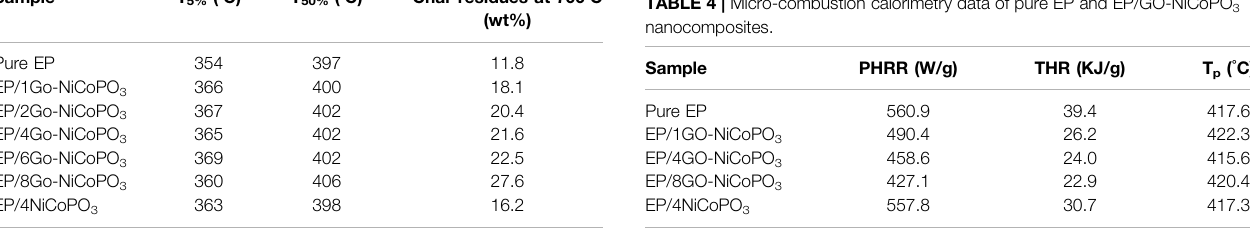
TABLE 2 | Thermogravimetric data of pure EP and EP nanocomposites. Sample